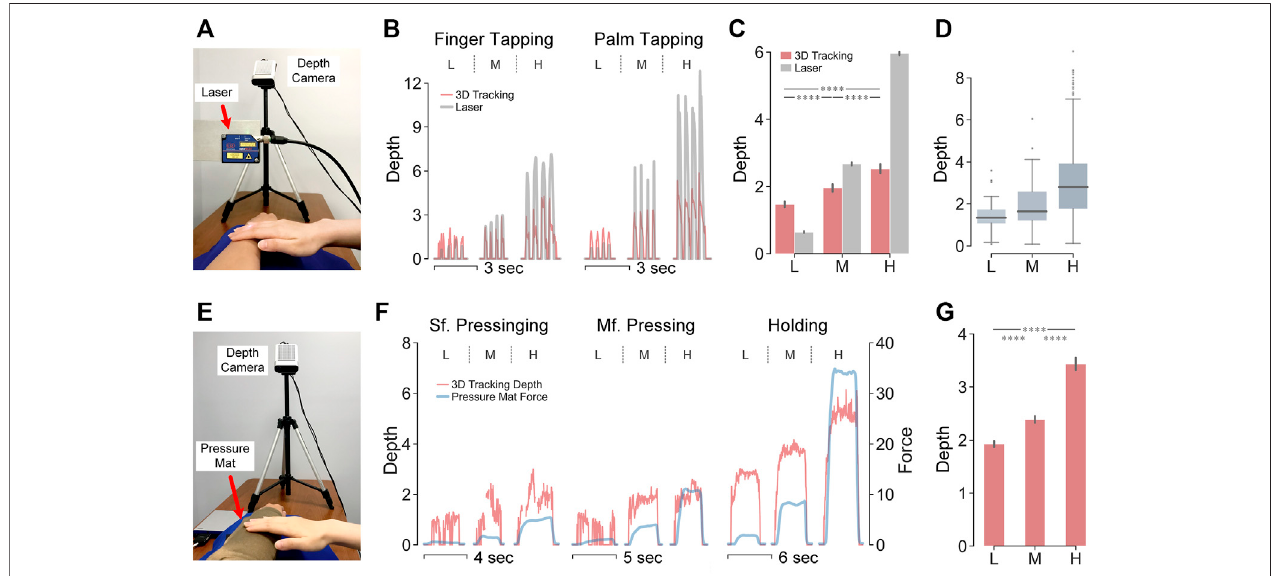
FIGURE 8 | Validation of indentation depth measurements using laser displacement sensor and sensorized pressure mat. (A) Experimental setup with laser displacement sensor. (B) Indentation depth (mm) over time by the either system. For the two test gestures shown is one trial per force level, i.e., low, medium, and high force. (C) Mean values of indentation depth per test gesture. **** p < 0.0001 were derived by paired-sample Mann – Whitney U tests across force levels. (D) Errors of measuredindentationdepthbetweensystemsperforcelevel. (E) Experimentalsetupwithsensorizedpressuremat. (F) Indentationdepth(mm)collectedbythe3D visual tracking system overlaps with overall force (N) collected by the sensorized pressure mat. Per test gesture, one trial per force level is shown i.e., low, medium, and highforce. (G) Meanvalueofindentationdepthperforcelevelrecordedbythe3Dvisualtrackingsystem.**** p < 0.0001werederivedbypaired-sampleMann – WhitneyU tests across force